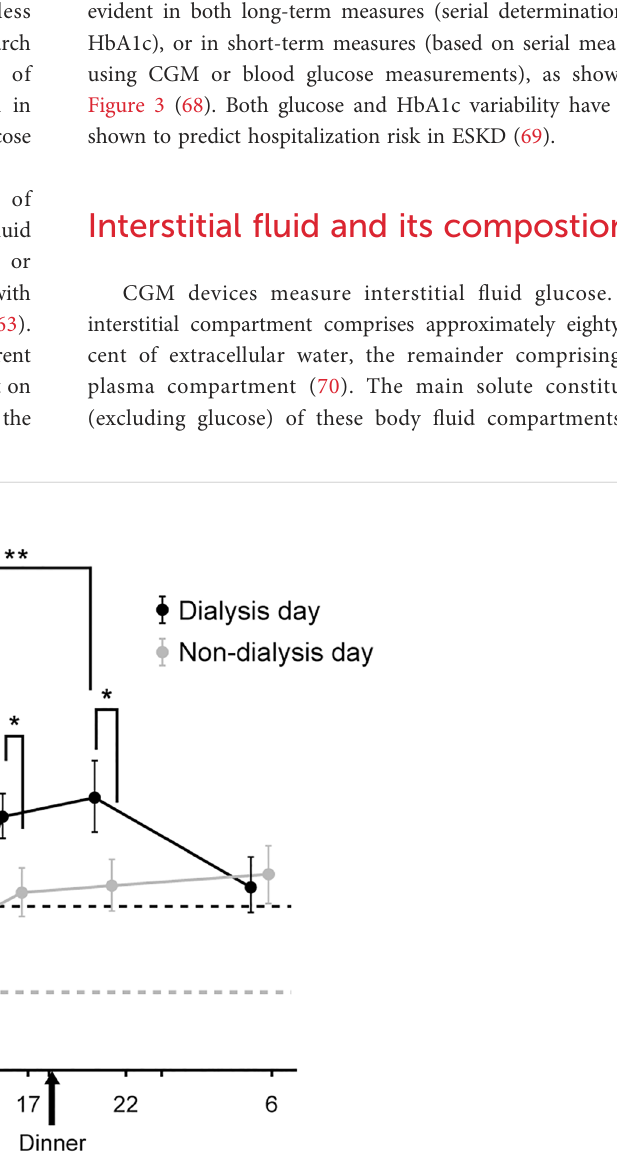
FIGURE 2 Circadian changes in plasma glucose level in hemodialysis patients with diabetes on dialysis day (dark line) and non-dialysis day (light line). *P<0.05; **P<0.01. (Adapted with permission from (63). HD, hemodialysis; SD, standard